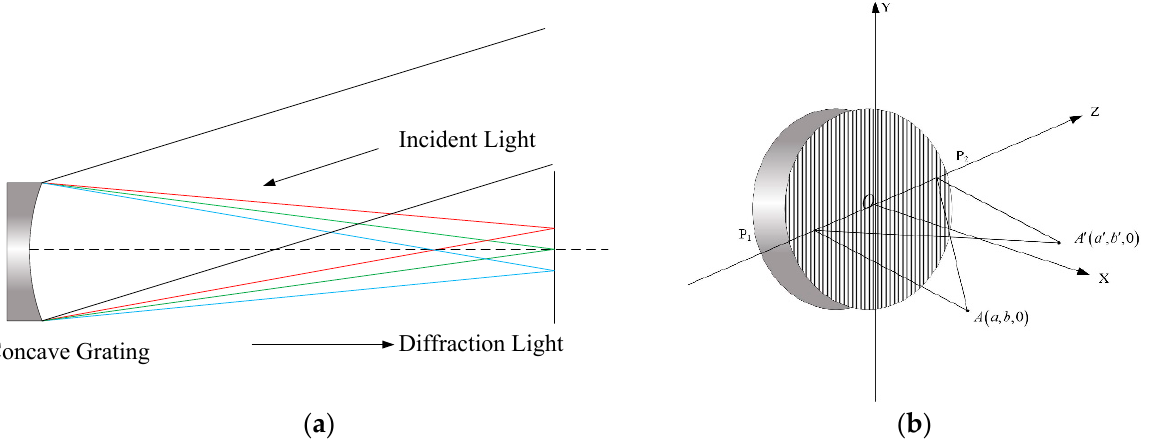
Figure 5. ( a ) The Wadsworth mounting is based on a concave grating. ( b ) Schematic diagram of the optical path of the concave grating.